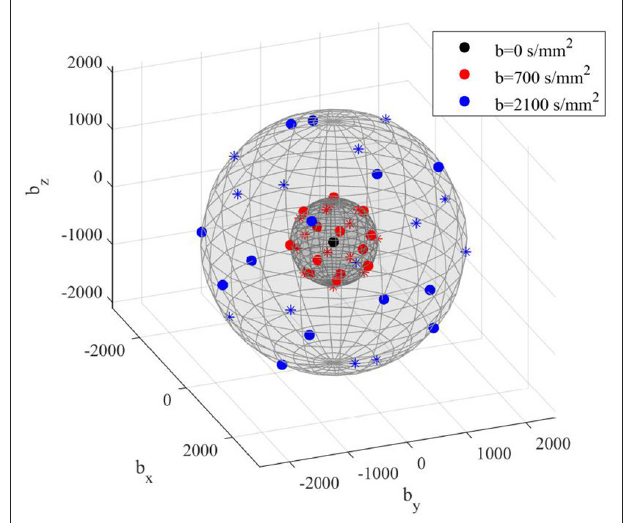
FIGURE 2 | 3D view of final diffusion acquisition scheme: directions of diffusion-sensitizing gradients relative to each b -value are displayed in three different colors as reported in the legend. Units are in s/mm 2 . Markers indicate polarity: dots are the polarities in the set; asterisks are their opposite.